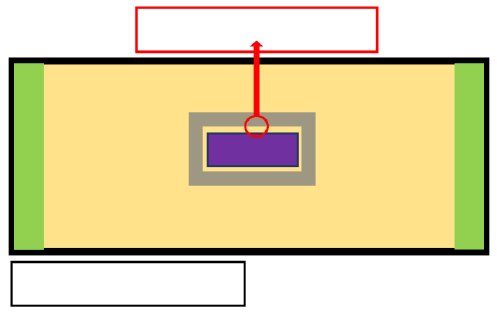
Figure 5. The Description of Separation Distance.